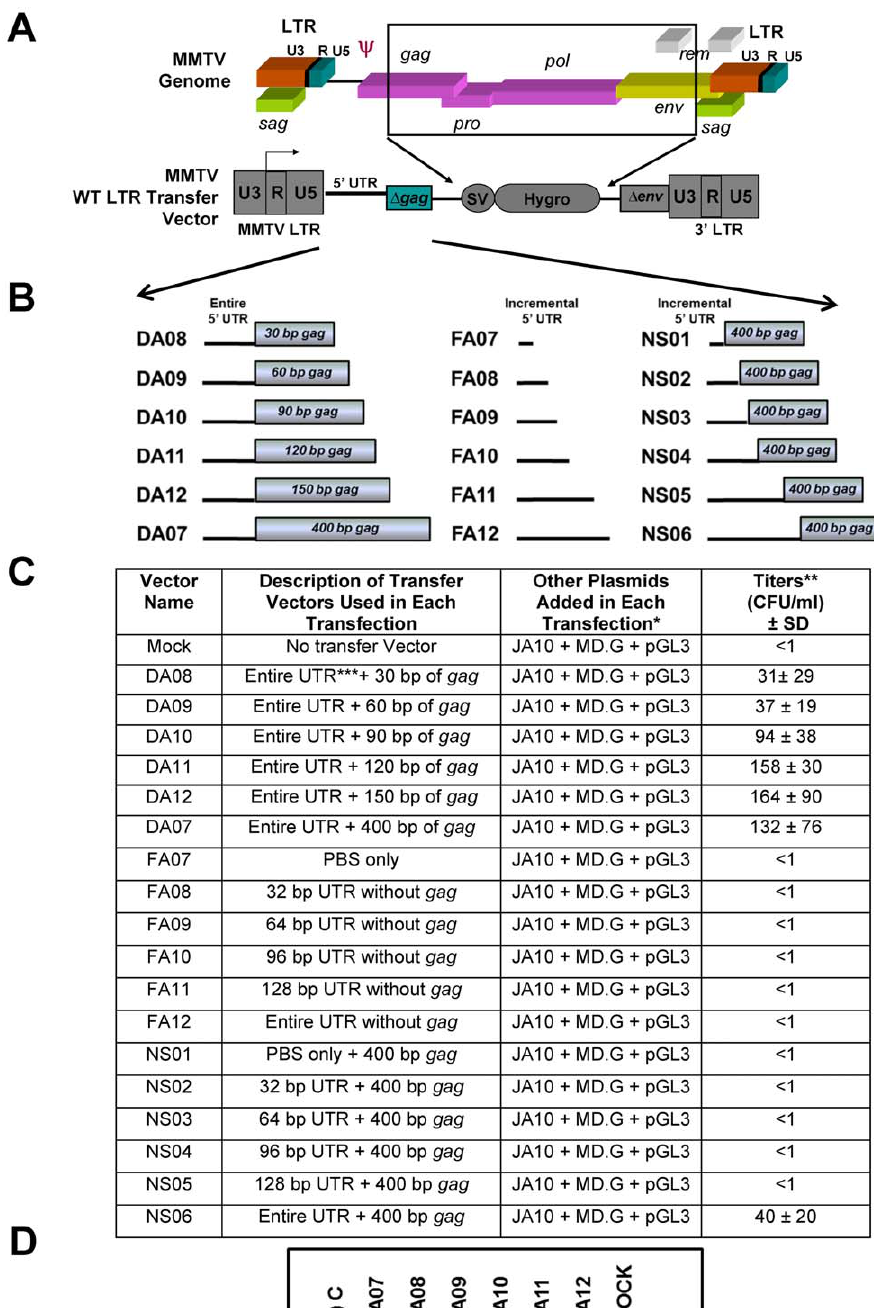
Figure 1. Experimental design to determine the role of the 5 9 untranslated region (UTR) and gag sequences in MMTV RNA packaging. ( A ) Schematic representations of the complete MMTV genome and the MMTV long terminal repeats (LTRs)-based transfer vectors used as RNA packaging substrates in the study. In these transfer vectors, the wild type (WT) MMTV LTRs were maintained and therefore following transfection the RNA transcription was initiated by the promoter sequences within the U3 region of the 5 9 LTR. Region encompassing most of the structural and enzymatic genes ( gag , pro, pol , part of env and rem ) were replaced by the SV-40 hygromycin resistance gene cassette as a marker for successful transduction of the target cells by packaged transfer vector RNA. ( B ) Three series of deletion mutations at the 5 9 end of MMTV transfer